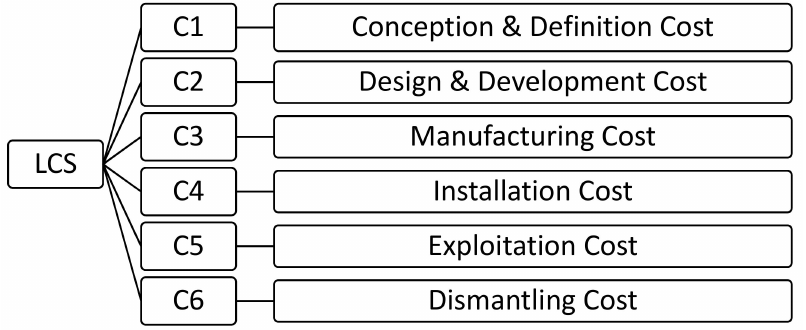
Figure 2. Life cycle system (LCS) phases. Source: